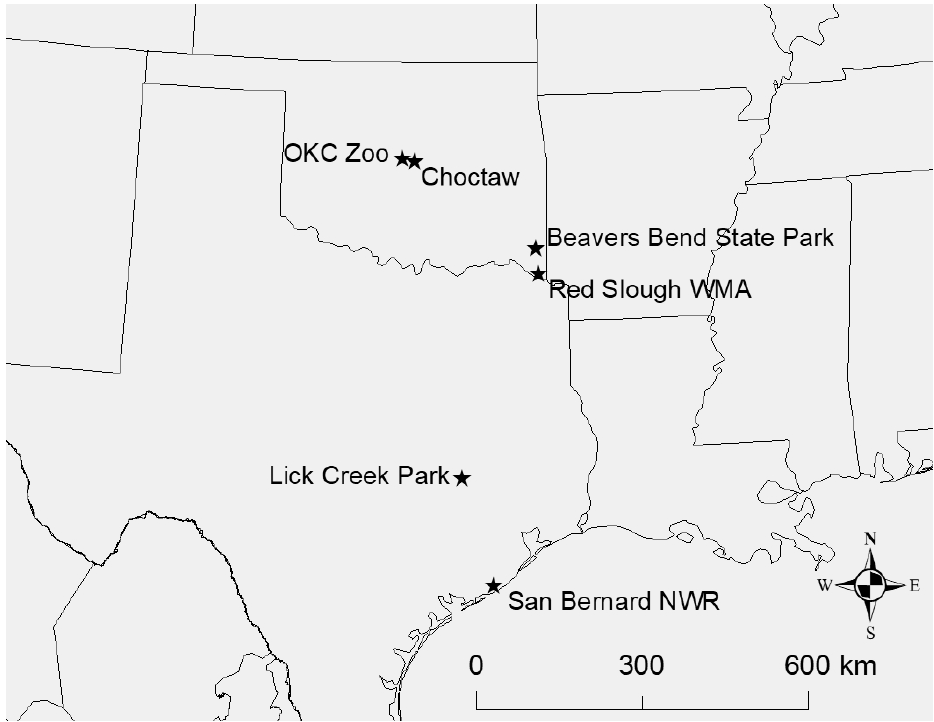
Figure 1. The locations in the US where palms were examined after the passage of winter storm Uri. Palms were examined at San Bernard National Wildlife Refuge in Brazoria County (Texas), Lick Creek Park in Brazos County (Texas), Red Slough Wildlife Management Area in McCurtain County (Oklahoma), Beavers Bend State Park in McCurtain County (Oklahoma), a private residence in Choctaw (Oklahoma County, Oklahoma), and the Oklahoma City Zoo (Oklahoma County, Oklahoma).